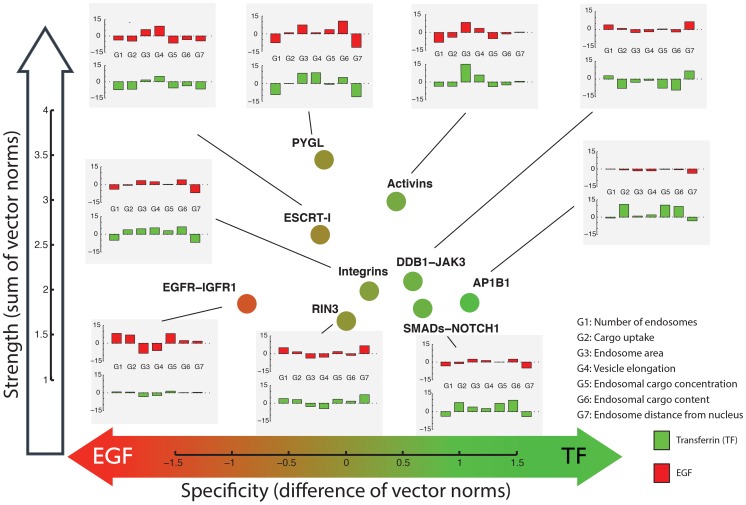
Selected network modules with enriched phenotypes.See Figure 4 legend for more details. The topology of the extracted sub-networks is shown in Figure S14. Note that genes in the same module (as opposed to protein complexes) can have anti-correlated profiles, but selected profiles of the same gene must be positively correlated. The profiles shown represent the direction taken by the majority of the genes in the module. E.g., the phenotype of EGFR is anti-correlated to the reference profile shown for the EGFR-IGFR module.